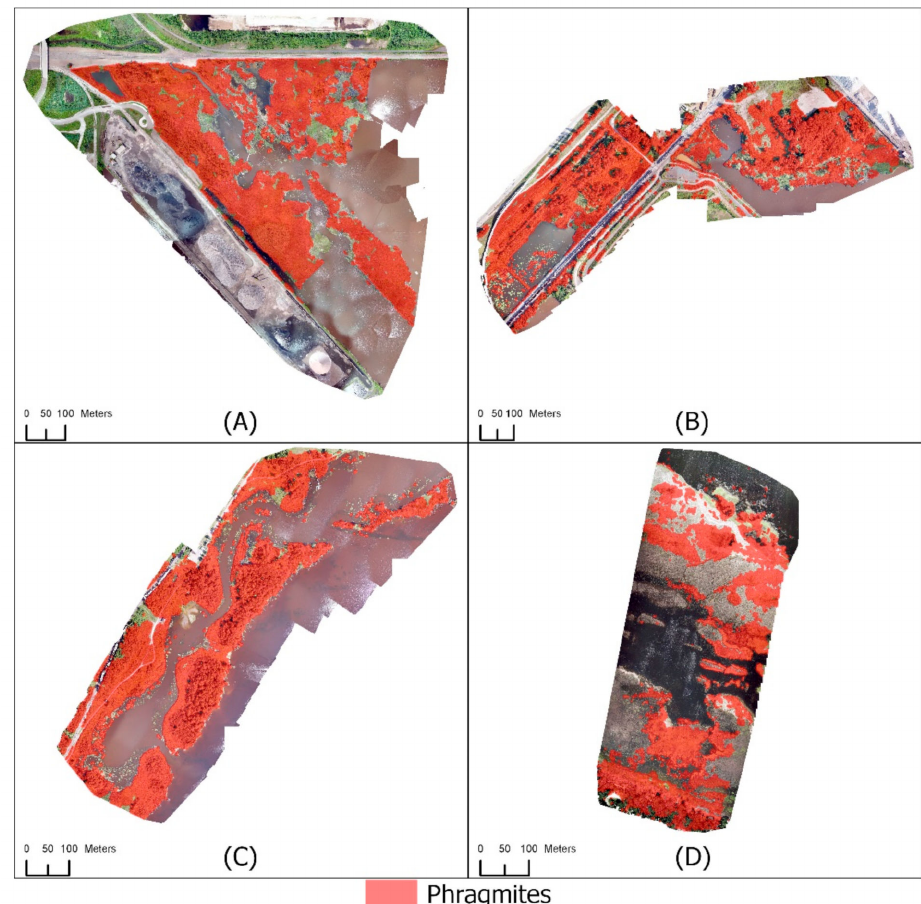
Figure 5. Mapping Phragmites using RGB UAS imagery without the use of a CHM or RADARSAT-2 HH polarization for ( A ) Grassy Point Park, ( B ) Hallett Dock, ( C ) Tallas Island, and ( D ) Saginaw Bay. Classifications using only the spectral and textural information from the RGB imagery (Scheme 1, Tables 2 and 3) exhibited low user’s accuracies for the Phragmites class (Table 6). The extent of Phragmites in each study area was significantly overestimated. All of the Phragmites validation points were correctly identified in Grassy Point Park, but 32 of the 85 Not Phragmites validation points were incorrectly identified as Phragmites . This resulted in a user’s accuracy of 58% for the Phragmites class. Saginaw Bay had a user’s accuracy of 48%. Thirty-three of the 37 Phragmites validation points were correctly identified at Saginaw Bay, but 36 Not Phragmites validation points were incorrectly classified as Phragmites . A similar response of widespread misidentification was seen in the Hallett Dock and Tallas Island study areas. Roughly 28% of the Hallett Dock study site and 33% of Tallas Island study site were misclassified as Phragmites . Forty-three of the 128 Not Phragmites validation points at Hallett Dock were incorrectly classified as Phragmites . Sixty-three of the 130 Not Phragmites validation points at Tallas Island were incorrectly classified as Phragmites . All study areas had user’s accuracies above 90% for the Not Phragmites